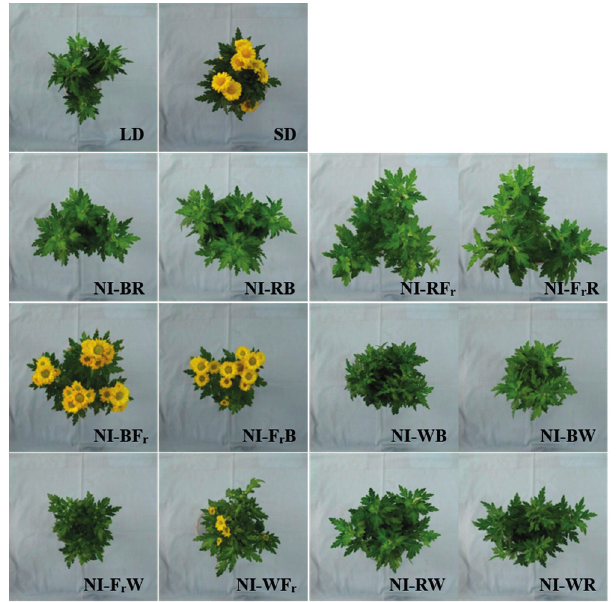
Figure 2. Effects of the shifts in the light quality of night interruption (NI) provided at 10 μ mol·m − 2 ·s − 1 PPF (photosynthetic photon flux) on the flowering of Dendranthema grandiflorum “Gaya Yellow” measured at 49 days after treatment: ( A ) side view and ( B ) top view. Table 1. Effects of shifting the light quality of night interruption (NI) provided at Dendranthema grandiflorum “Gaya Yellow”, measured at 49 days after treatment. Treatment DVB y (Day) Number of Flowers/Plant